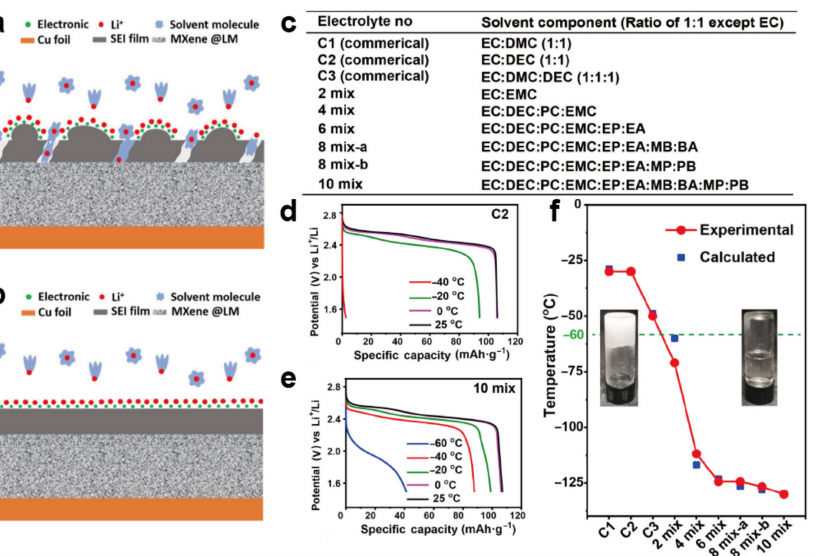
Figure 6. Schematic diagram of the electrode surface film before ( a ) and after ( b ) using the MB electrolyte at low temperature [109]. Reproduced with permission from Chinese Journal of Chemistry; published by Wiley-VCH Verlag GmbH & Co. KGaA, 2021; ( c ) solvent compositions of commercial electrolytes and the designed multicomponent high-entropy electrolytes with 1 M LiPF 6 and fluo- roethylene carbonate (FEC) as additives; ( d , e ) discharge curves of LiMn 2 O 4 /LTO full cell with C2 and 10 electrolyte mixtures at 0.1 C under different temperatures; ( f ) the freezing point of various electrolytes [111]. Reproduced with permission from CCS Chemistry; published by Chinese Chemical Society,